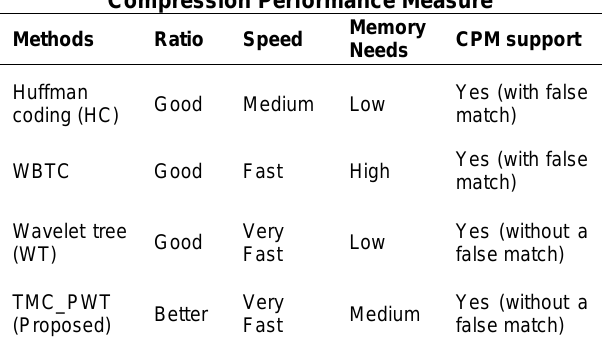
Table 19: Comparison between methods that